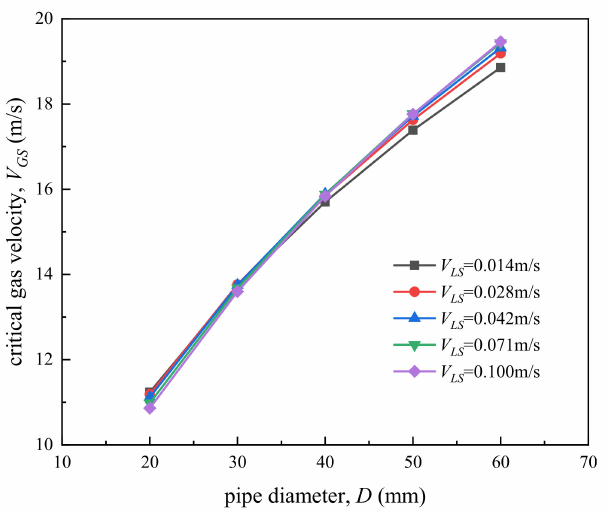
Figure 5. The relationship between critical liquid-carrying gas velocity and pipe